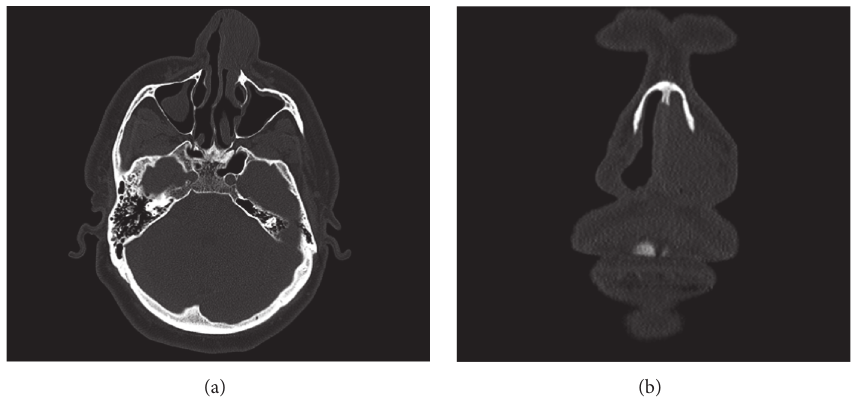
Figure 1: (a) shows axial and (b) shows coronal CT images. Both show a soft tissue mass occupying the left nasal vestibular area.